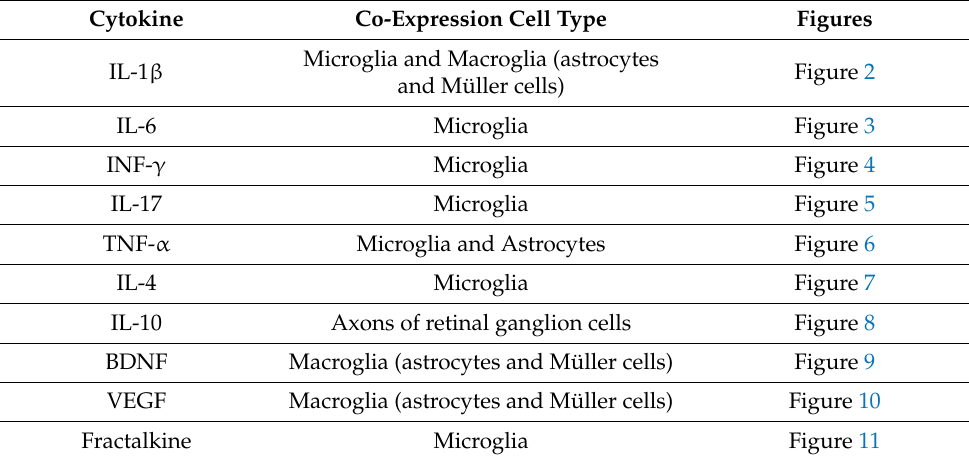
The table represents the cells showing the expression of the different cytokines and factors used in this study: interleukin 1 beta (IL-1 β ), interleukin 6 (IL-6), interleukin 17 (IL-17), interferon gamma (IFN- γ ), brain-derived neurotrophic factor (BDNF), vascular endothelial growth factor (VEGF), fractalkine (CX3CL1), tumour necrosis factor alpha (TNF- α ), interleukin 4 (IL-4), and interleukin 10